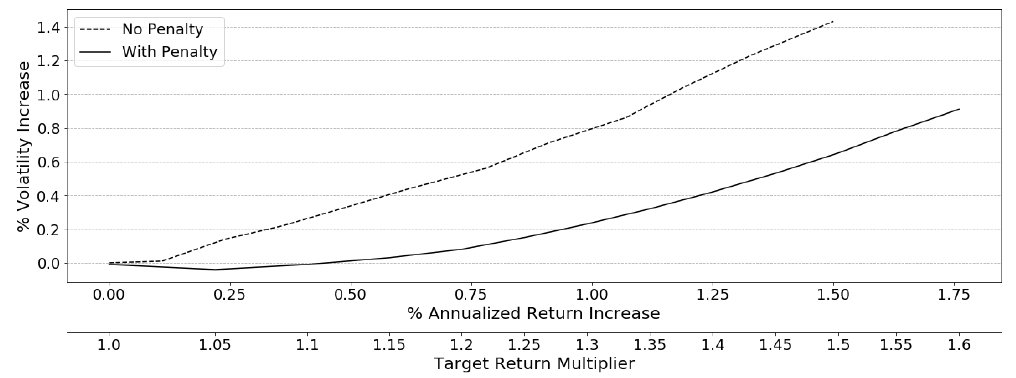
Figure 11. Out-of-sample volatility cost of enhanced returns—1997–2018.